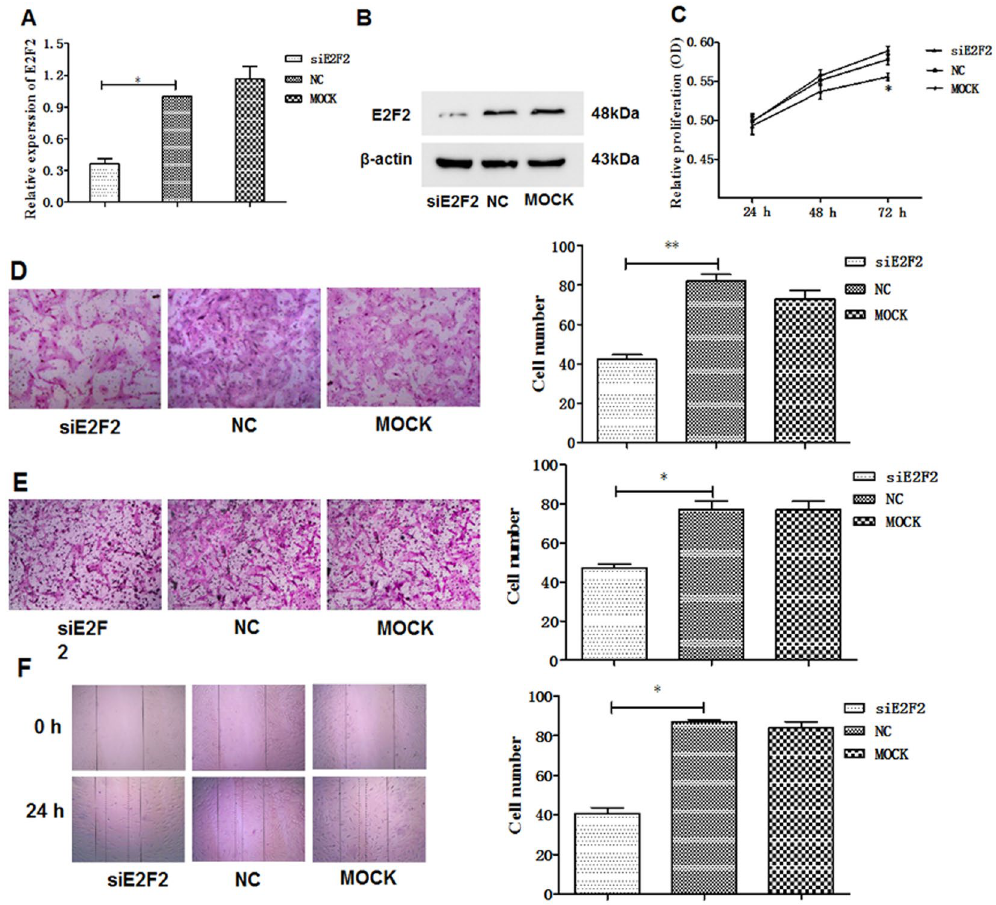
Figure 2. Effect of E2F2 on RASFs proliferation, invasion, migration. A-B , RASFs were transiently transfected with siRNA targeting E2F2.Resultant expression was detected using qPCR ( A ) and western blot ( B ). The E2F2 mRNA level and protein levels were both normalized to β -actin. ( C) , MTS assay was used to assess cell proliferation. ( D ), The invasive ability was performed by transwell assay and the average number of cells that invaded through the filter was quantified. E-F , Migration capacity of RASFs 24 h after silencing E2F2 by transwell( E ) and scratching( F ). Results of statistical analyses of three independent determinations. NC: negative control; MOCK: transfection-reagent control. Values are expressed as mean ± SD of the mean and at least 3 independent experiments were performed; * p <